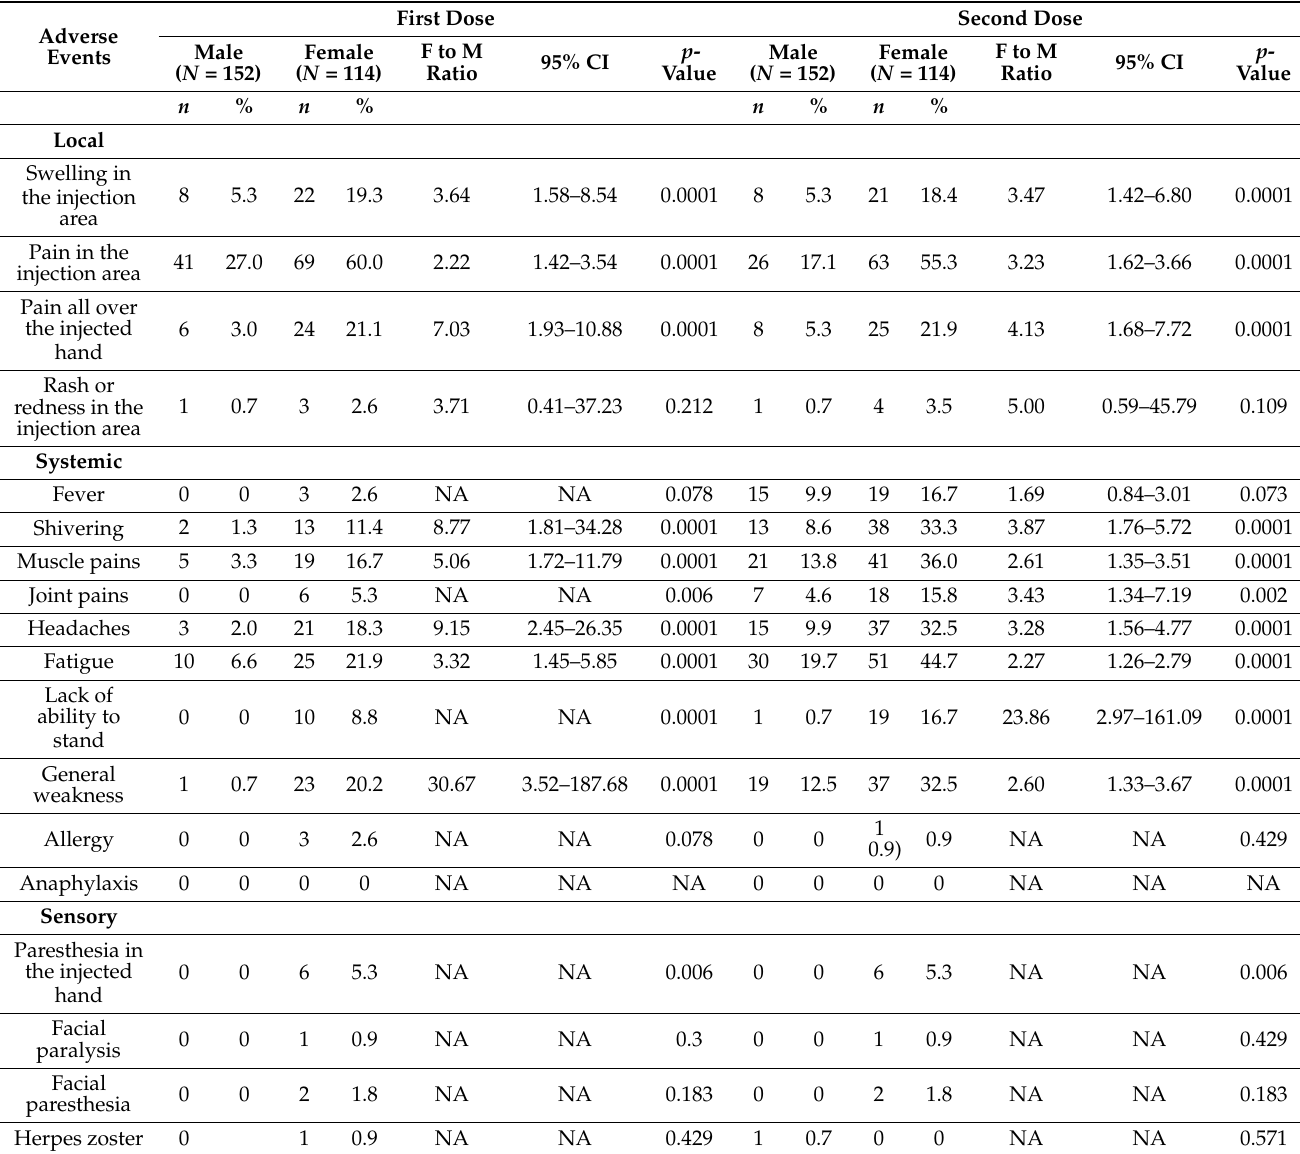
Table 2. Female-to-male ratio of the percentage reporting moderate or severe adverse events following the Pfizer-BioNTech COVID-19 vaccine in a cross-sectional study.